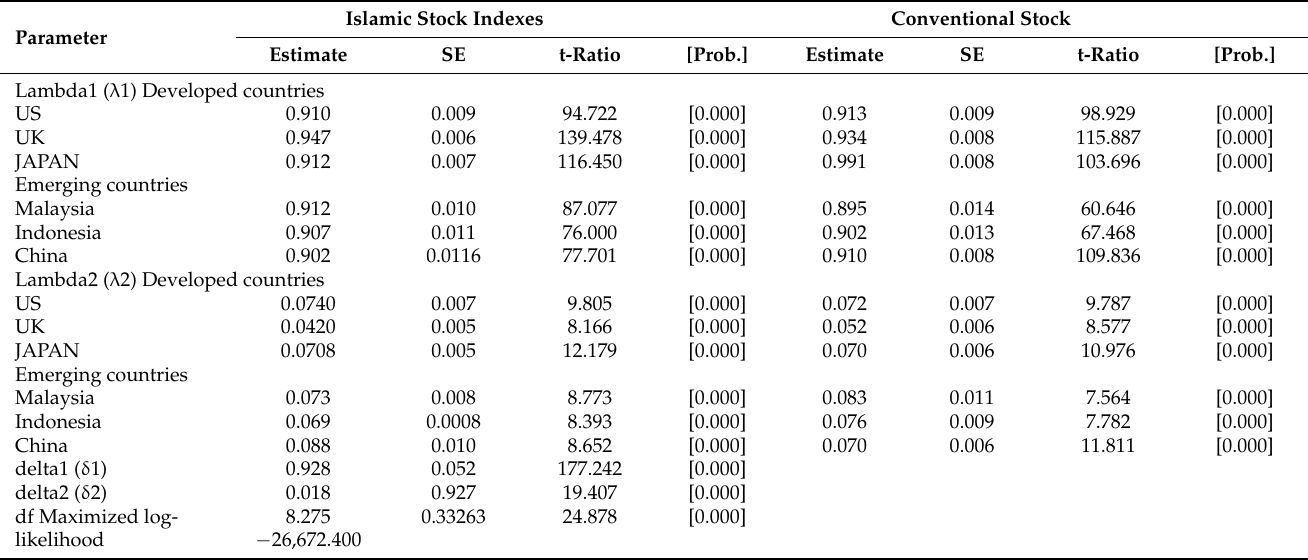
Table 4. t-DCC model for maximum likelihood